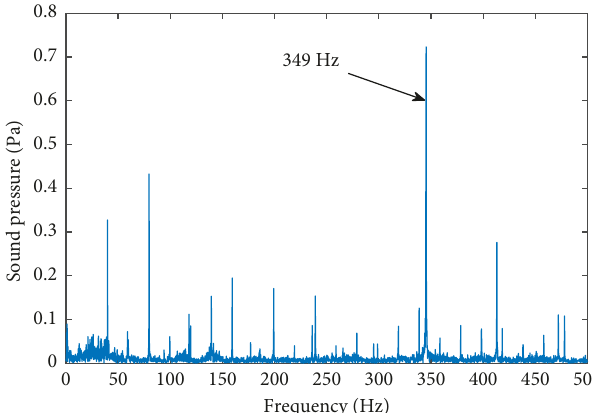
Figure 8: Amplitude spectrum of parotic noise sound under the working condition of